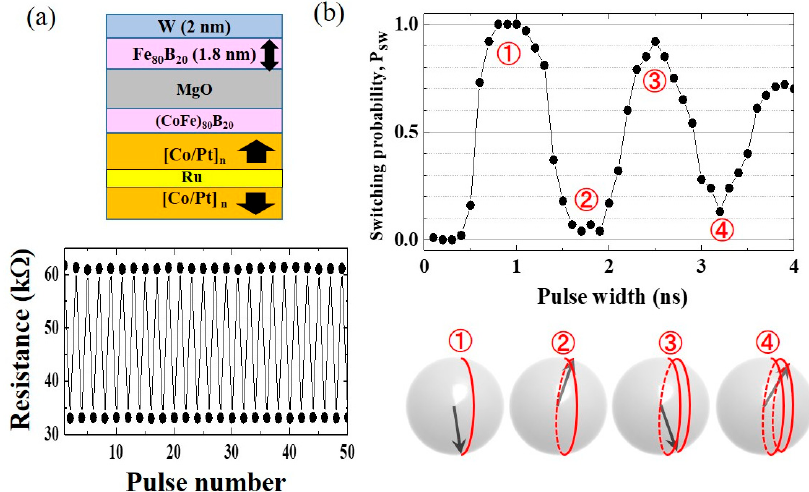
Figure 5. Experimental demonstration of voltage-induced dynamic switching. ( a ) Schematic of the sample structure of a voltage-controlled perpendicularly-magnetized MTJ and observed bi-stable switching between parallel and antiparallel magnetization configurations induced by successive pulse voltage applications. ( b ) Pulse width dependence of switching probability, P SW . Due to the precessional dynamics, P SW exhibits oscillatory behavior depending on the pulse width.